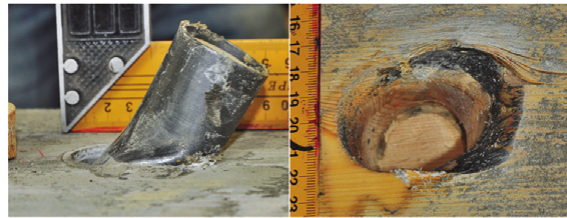
Fig. 9. D42 wood sample failure (steel in shear and wood in compression)